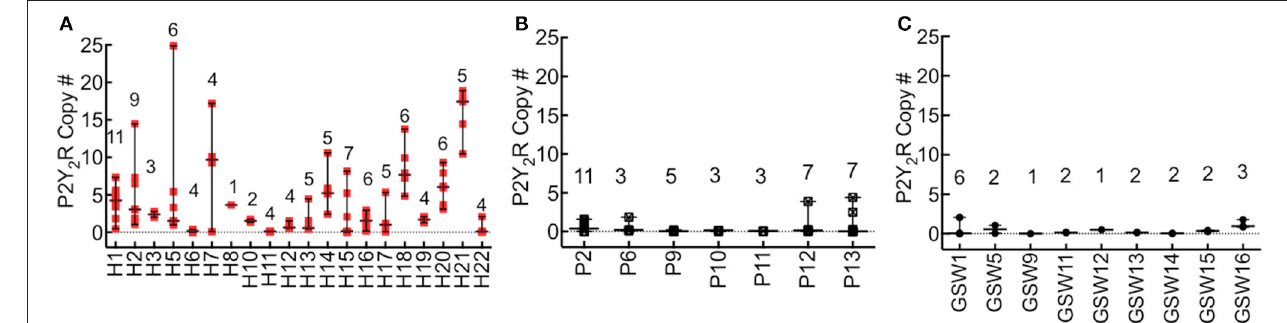
FIGURE 3 | P2Y 2 R expression is significantly upregulated in HCPS compared to controls. RNA was extracted from lung tissues samples with the Qiagen RNeasy FFPE kit (cat# 73504) and quantified with a Thermo Fisher Scientific Nanodrop. P2Y 2 R expression levels were measured by the TaqMan assay using a WT P2Y 2 R plasmid as standard. P2Y 2 R copy #s were normalized to total RNA extracted from the embedded tissues. Each sample slice was measured in triplicate. (A) The plot of P2Y 2 R for each HCPS patient, shown on the x-axis as H1-H22. Each data point per patient represents a triplicate measurement of P2Y 2 R expression in a 10 µ m slice cut from the FFPE blocks. The number of segments analyzed is shown for each case above the replicate data points (e.g., n = 11 for H1). Ninety-seven distinct segments from all cases were analyzed. Lung tissues from two decedents (H4, and H9) were not available. The error bars represent the median and range. For all HCPS samples, the minimum, median, maximum and mean values were 0.0055, 2.10, 24.88, and 4.1 ± 0.48 (SEM). (B,C) Plot of P2Y 2 R for pneumonia (P) and gunshot wound cases (GSW). The experimental conditions are similar to those described for HCPS. Cases for which no lung tissue samples were available were excluded from the graph. For all pneumonia tissue segment samples ( n = 39), the minimum, median, maximum and mean values were 0.0005, 0.07, 4.4, 0.54 ± 0.16. For all GSW samples ( n = 21), the minimum, median, maximum and mean values were 0.0052, 0.18, 2.4, and 0.46 ± 0.10 (SEM).